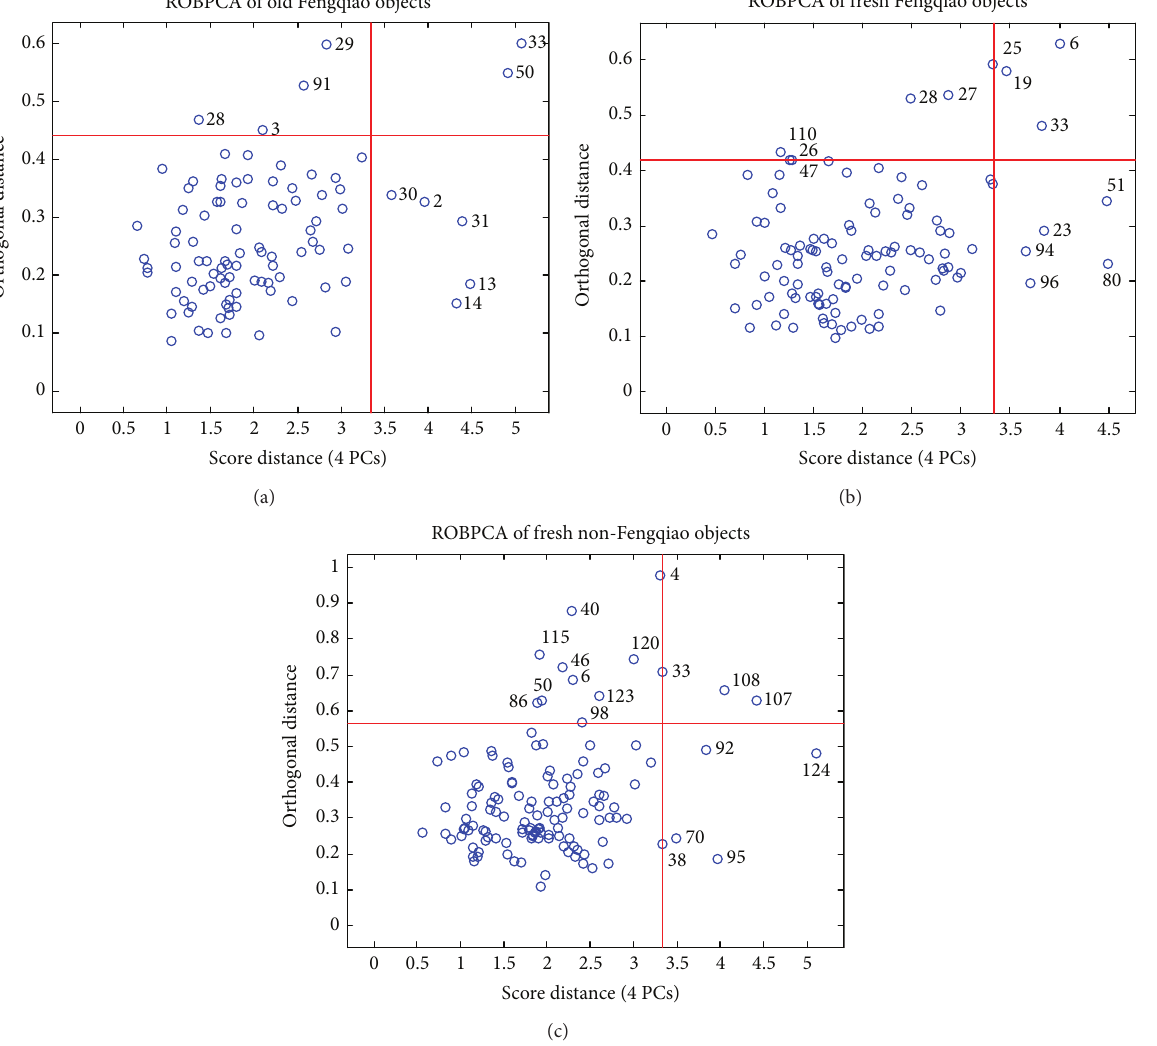
Figure 3: ROBPCA outlier diagnosis plots of the three classes of seed kernels based on raw spectra (4000–9000 cm −1 ).